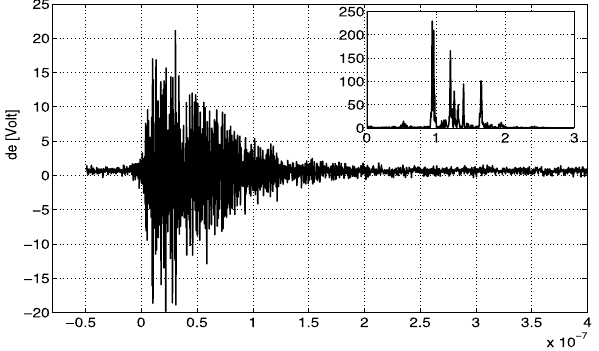
Figure 12. A FC signal registered during the PALS experiment. The inset shows the Fast Fourier transformation of the